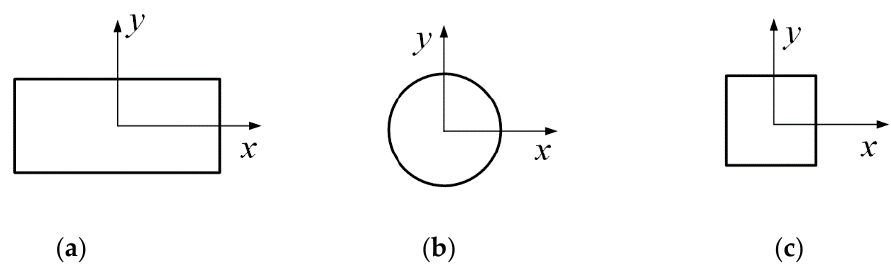
Figure 2. Local coordinate system for the components of ( a ) pontoon, ( b ) brace and ( c ) deck. Table 1. Dimension and hydrostatic properties of the semi-submersible platform.